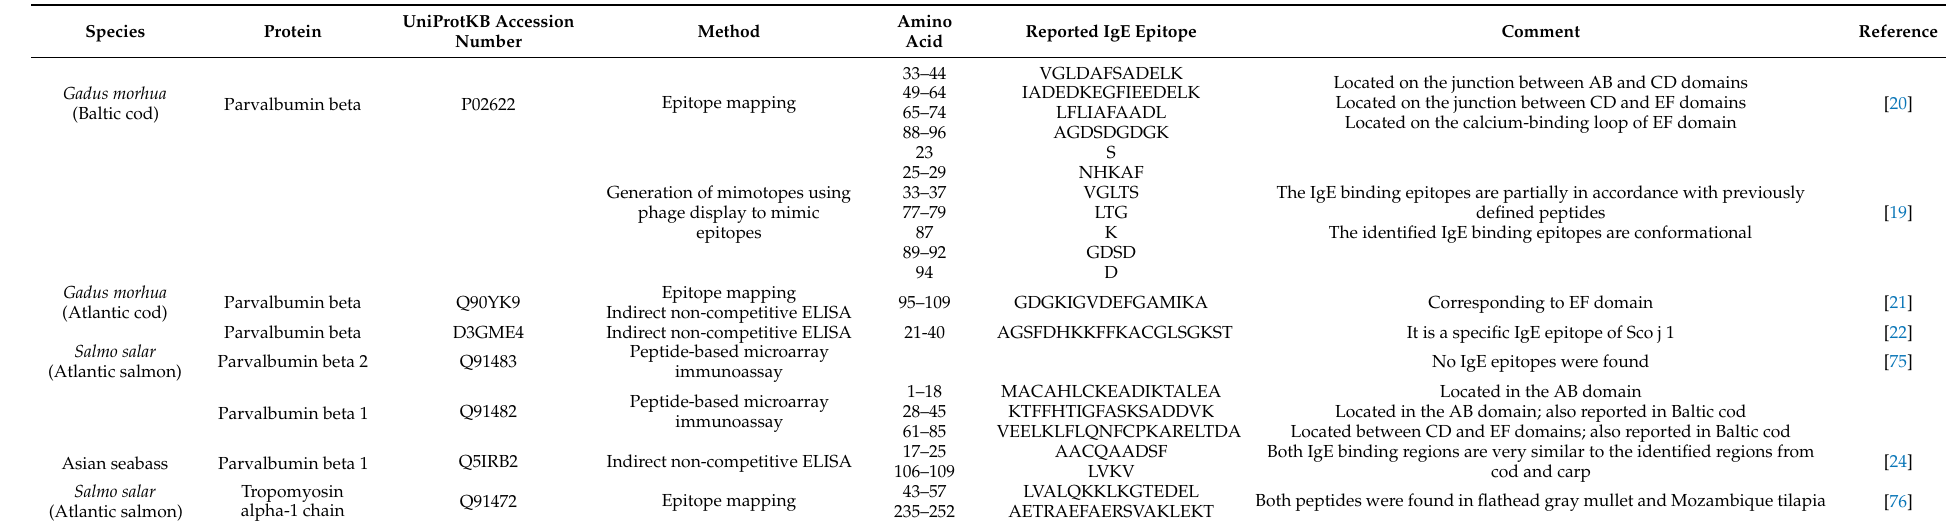
Table 2. Reported IgE epitopes of fish allergens from